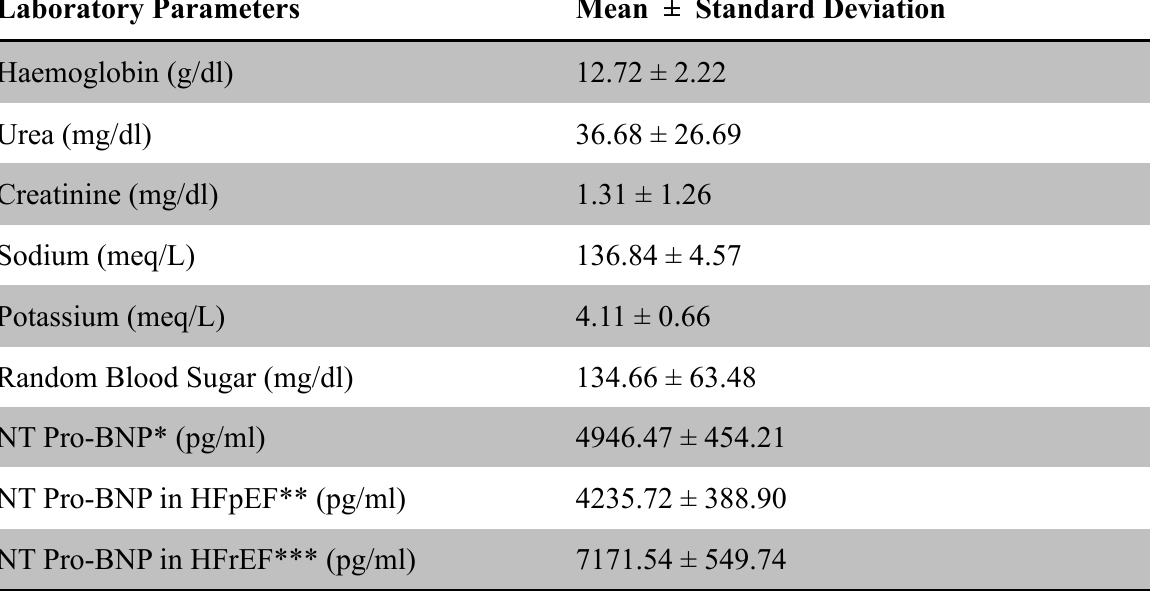
Table 2: Investigations findings in the study population (n=116)